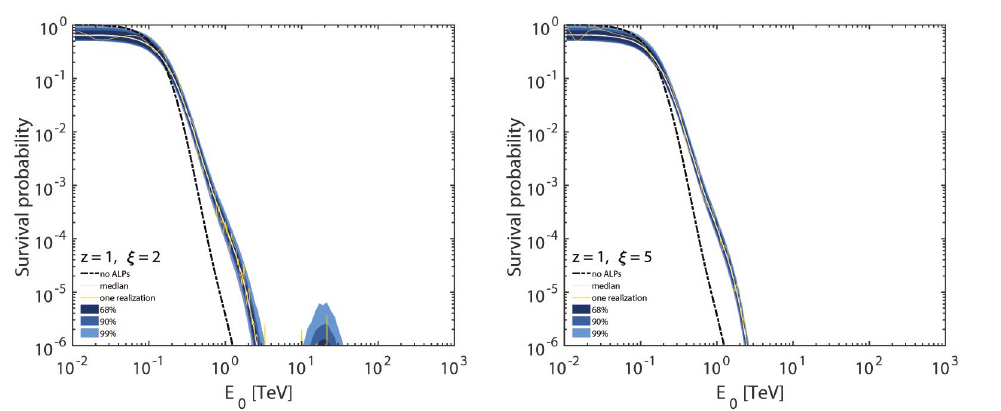
Figure 22. Same as Figure 17 apart from z = 1. (Credit [115]). Figures for z = 2.